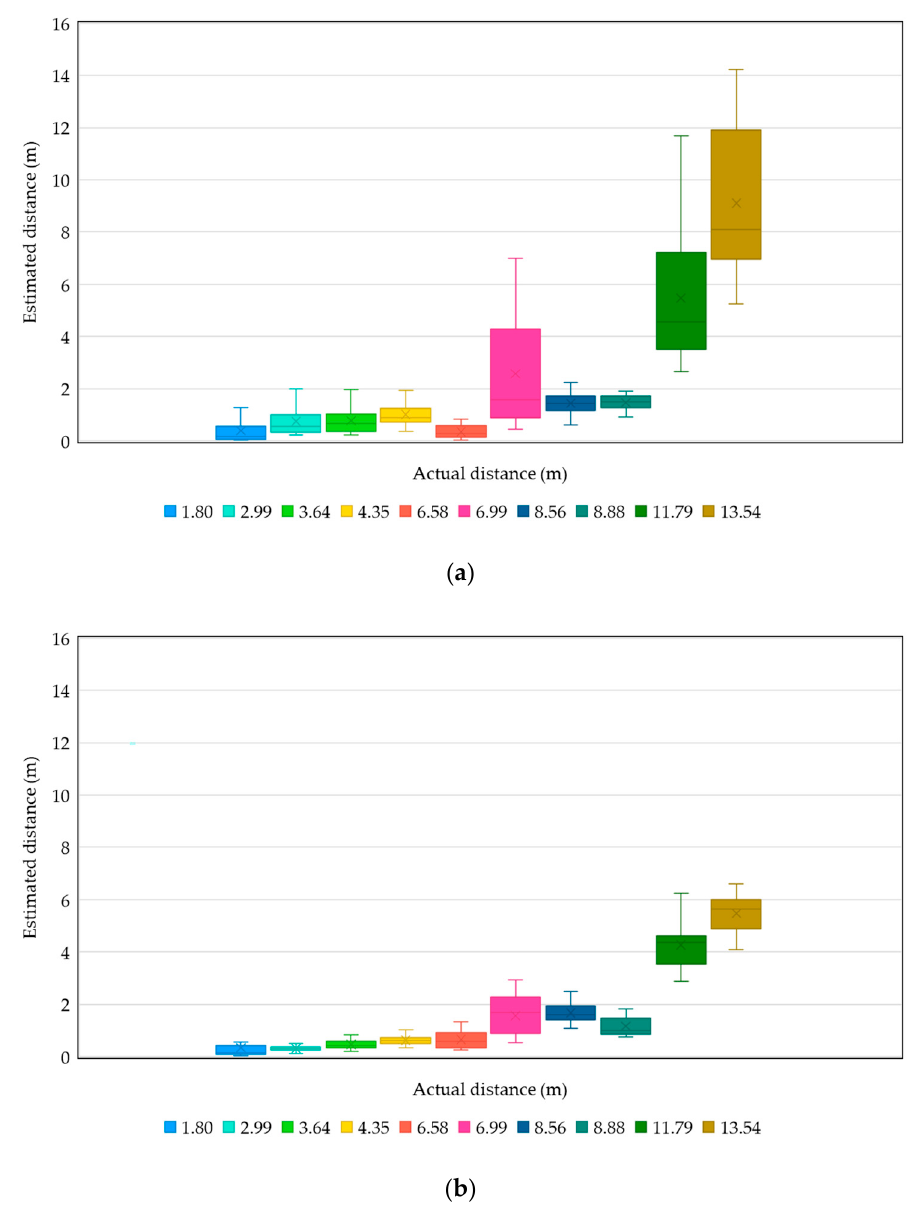
Figure 15. Boxplots of transmitter-to-receiver distance estimations: ( a ) data from the first 5 min ( b ) data from the second 5 min.